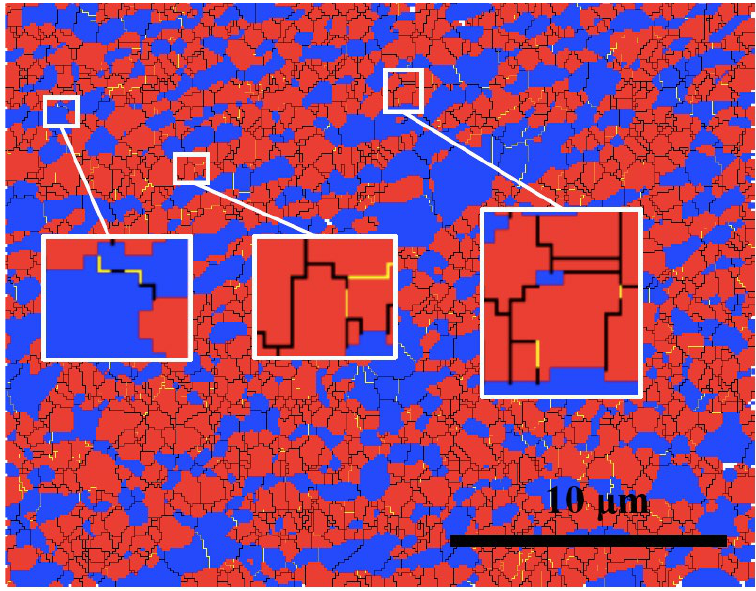
Figure 11. Grain boundary map of region c (LABs and HABs are in yellow and black, respectively). The variation in grain size of austenite and ferrite along the centerline is illustrated in Figure 12. Lakshminarayanan and Balasubramanian [36] found that greater strain and more severe plastic deformation were produced near the tool shoulder as compared to the region away from the shoulder, leading to a finer grain structure near the surface. Thus, the grain sizes of both phases show an increasing trend from the top surface (0.1 mm) to 0.8 mm. Although the strain kept on decreasing along the depth of the centerline, temper- ature shows a predominant influence on the microstructure [13]. The descending temper- ature resulted in finer grain at the bottom of the SZ (i.e., region c), which is due to the lower temperature and higher cooling rate at the bottom [28].